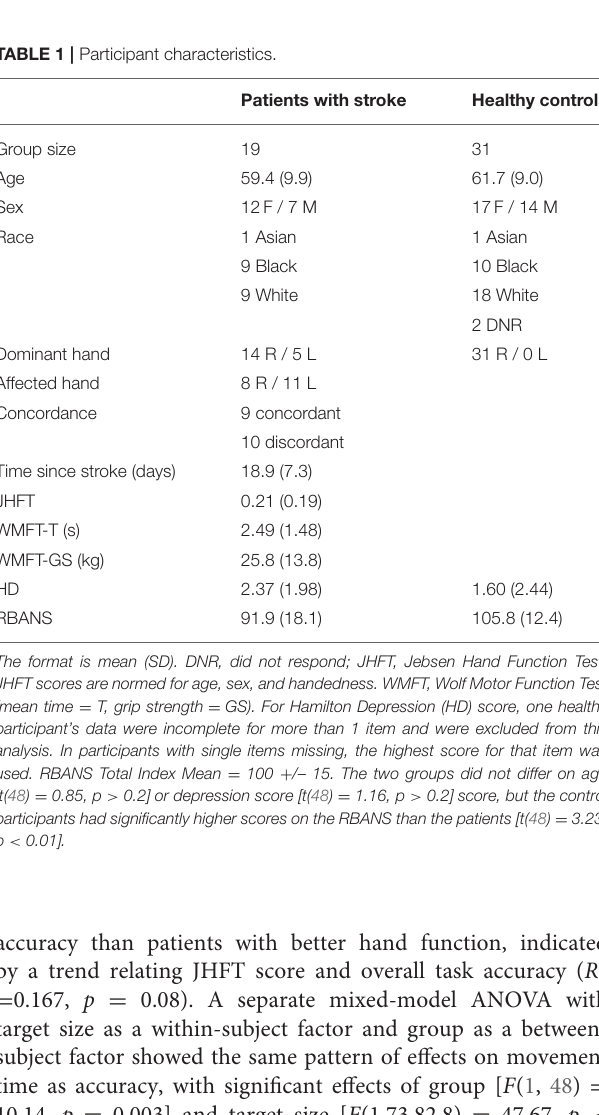
TABLE 1 | Participant characteristics.